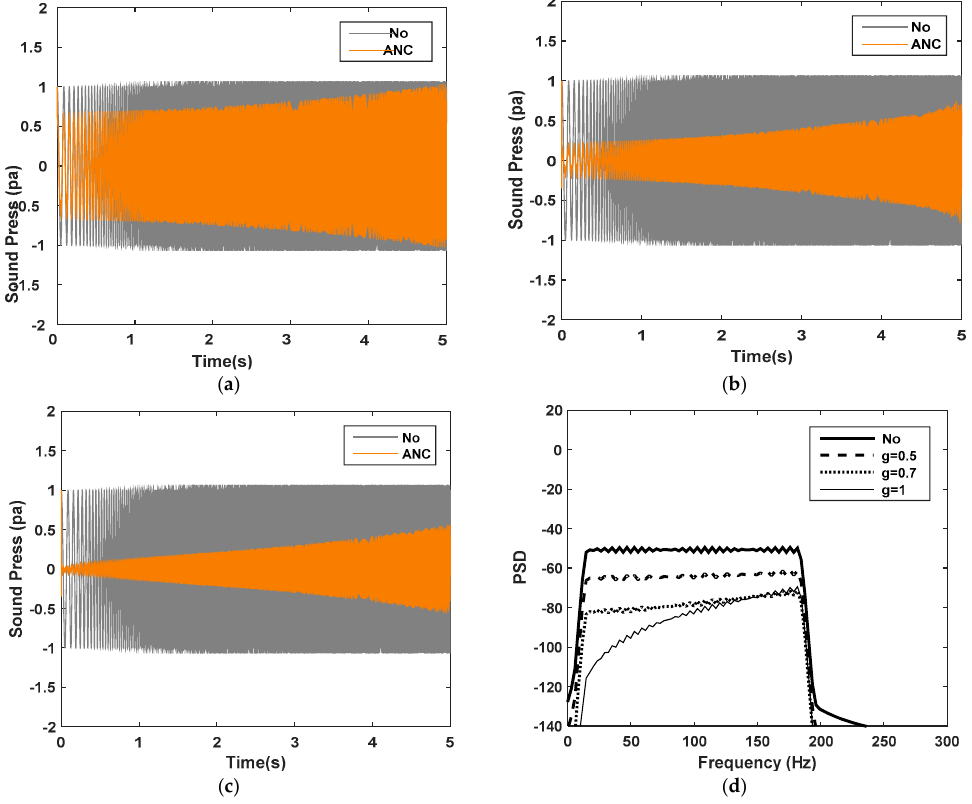
Figure 4. Time history and PSD of signal 1 controlled by the NLMS algorithm-based adaptive notch filter with two weights ( L = 2) and leakage factor ( γ = 0.5). ( a ) Time history ( γ = 0.5); ( b ) Time history ( γ = 0.7); and ( c ) Time history ( γ = 1); and ( d ) PSD.